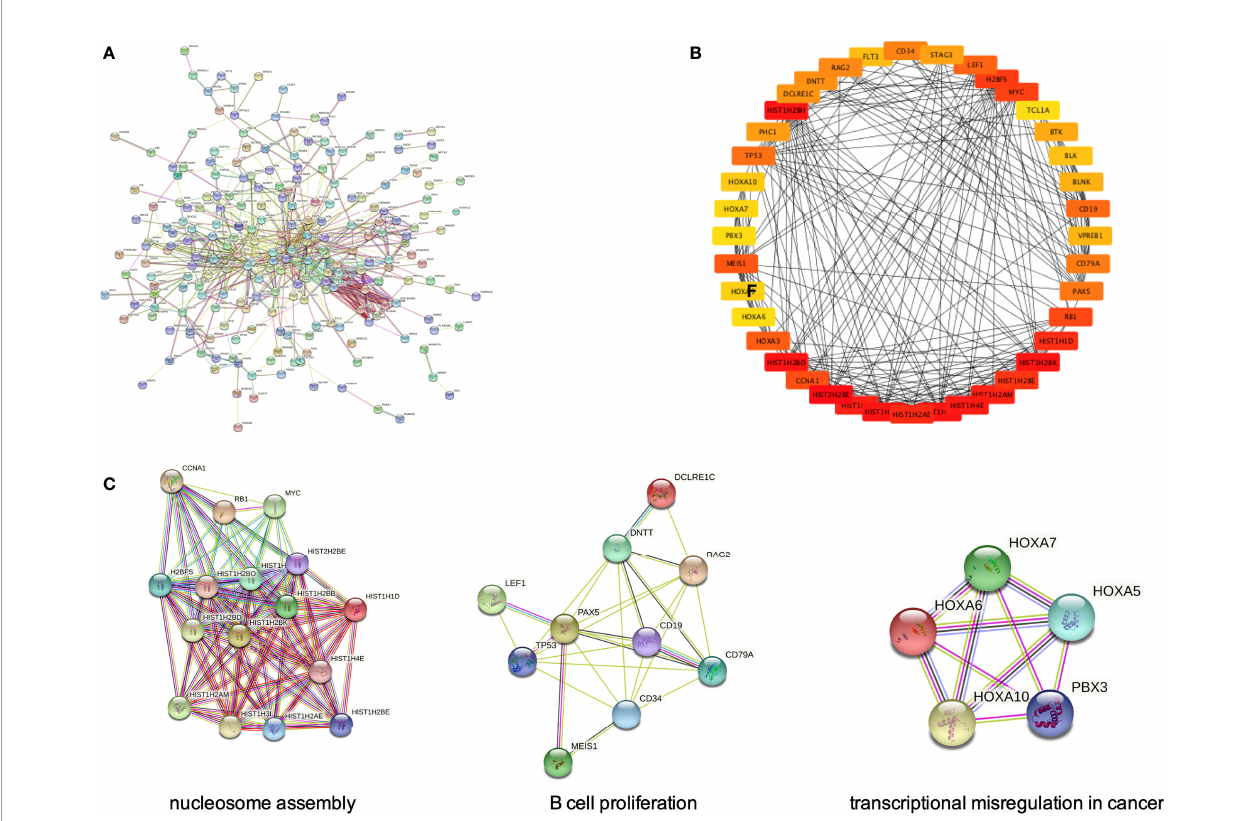
FIGURE 4 | PPI networks of upregulated DEGs by STRING Search Tool. (A) The PPI network was constructed by STRING based on upregulated DEGs. (B) The 40 genes with highest CytoHubba scores were shown in a circle. The color scheme of each node from red to yellow represents the scores from high to low, respectively. (C) The genes with highest CytoHubba scores made up three critical